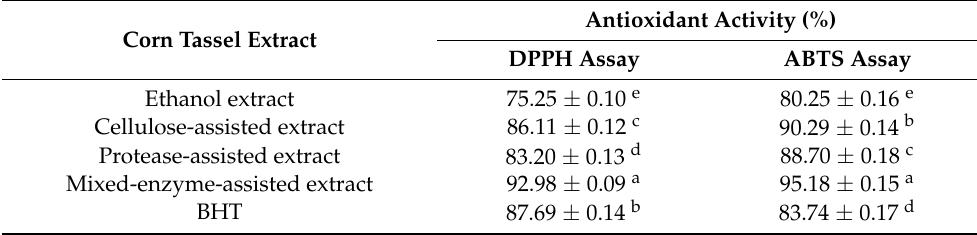
Table 3. In vitro antioxidant activity of the different corn tassel extracts from ethanol and enzyme- assisted extraction.